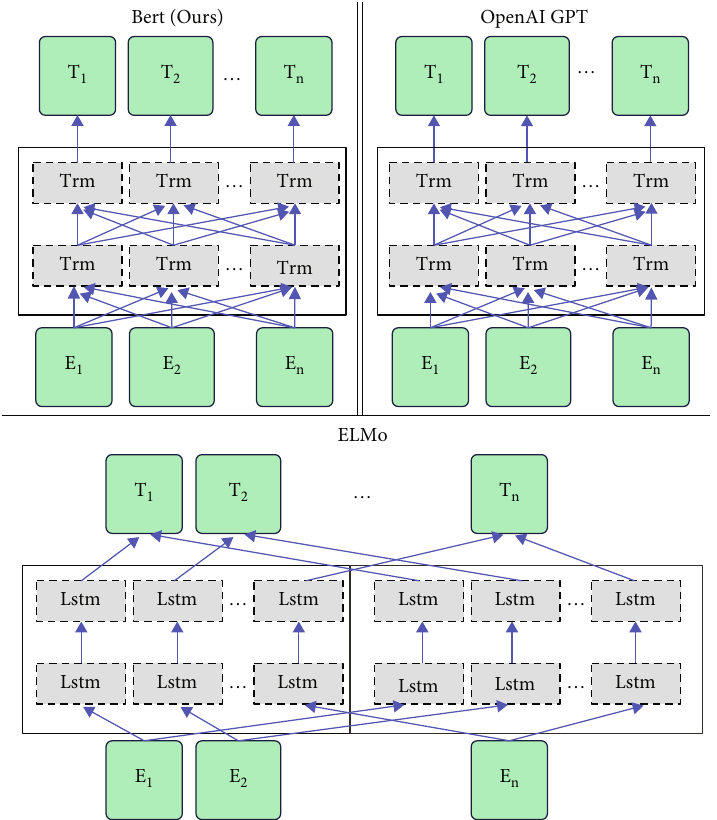
Figure 2: Structure comparison diagram of the three